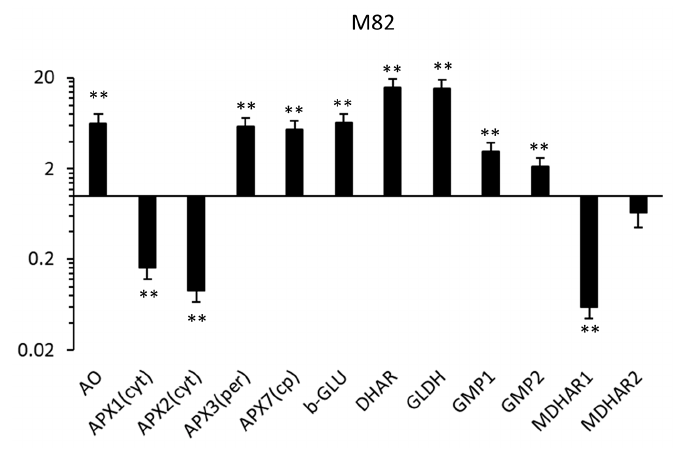
Figure 6. Figure 6. Cont.